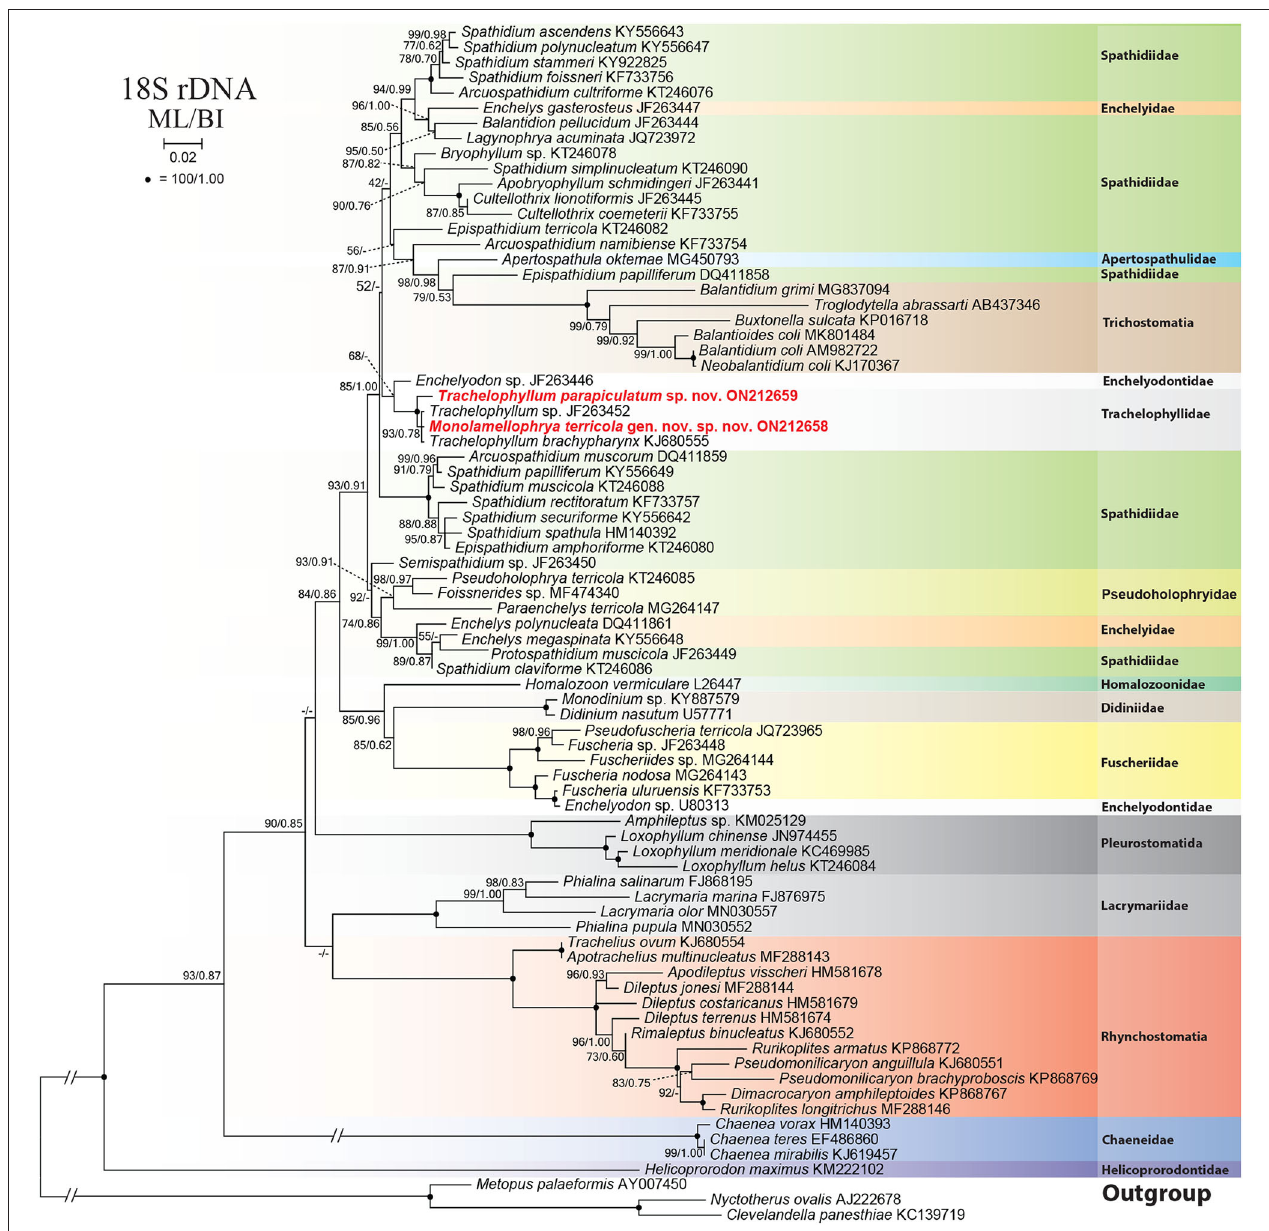
FIGURE 7 | Maximum likelihood (ML) tree based on 18S rRNA gene sequences, showing the phylogenetic position of Monolamellophrya terricola gen. nov., sp. nov. and Trachelophyllum parapiculatum sp. nov. Newly obtained sequences are in bold. GenBank accession numbers follow species names. Numbers at the nodes represent the maximum likelihood (ML) bootstrap values and the Bayesian inference (BI) posterior probabilities. Dashes indicate bootstrap values < 50%, posterior probabilities < 0.5, or different topologies in BI and ML phylogenies. The scale bar represents two nucleotide substitutions per 100